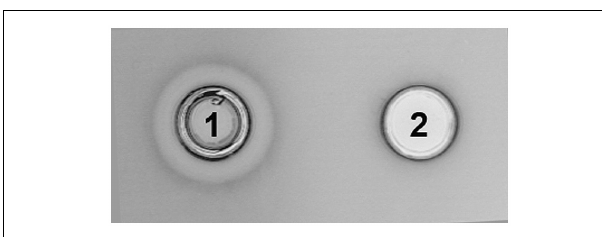
FIGURE 2 |Analysis of bacteriocin inactivity of BGMN1-501/pG + host9lcnB integrant. (1) BGMN1-501, (2) lcnB integrant.